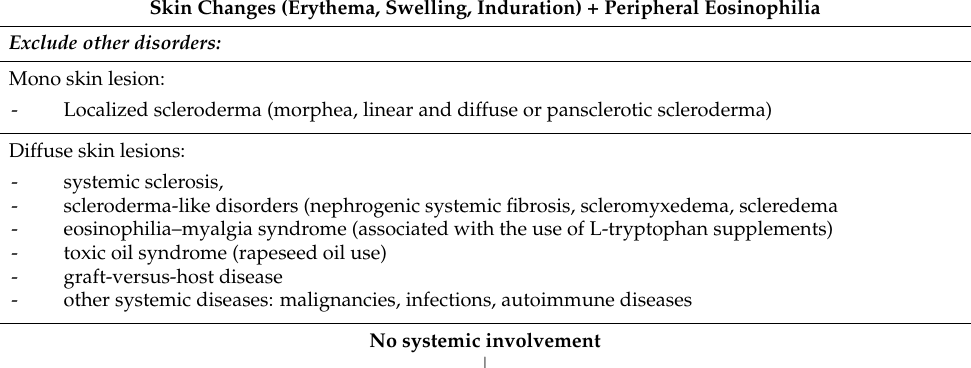
Table 3. A simplified approach to the diagnosis/differential diagnosis of